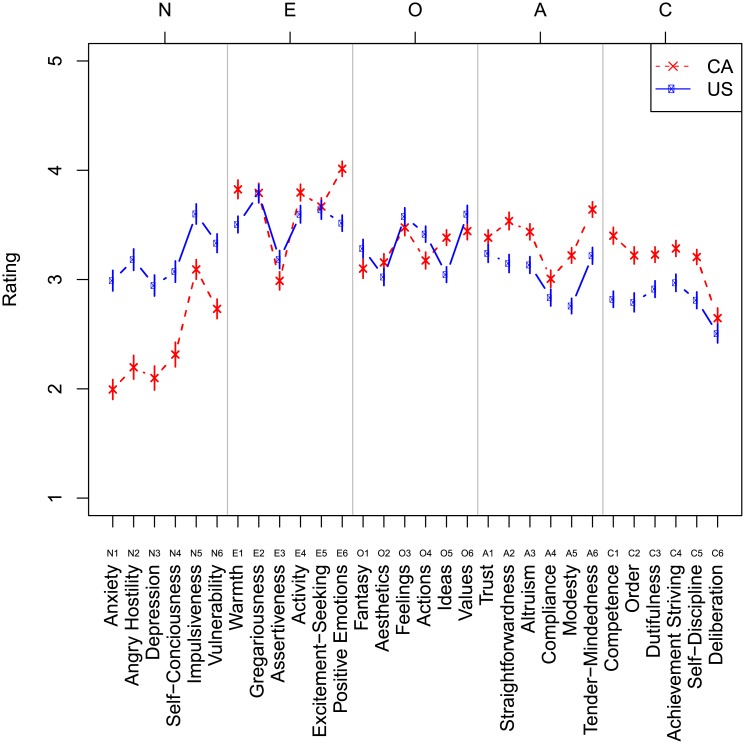
Mean ratings for 30 scales of the modified National Character Survey, based on word and emoji characteristics of the US (blue) and Canada (red). Error bars stand for 1 standard error of the mean adjusted using the method of [95] for within-participants comparison.